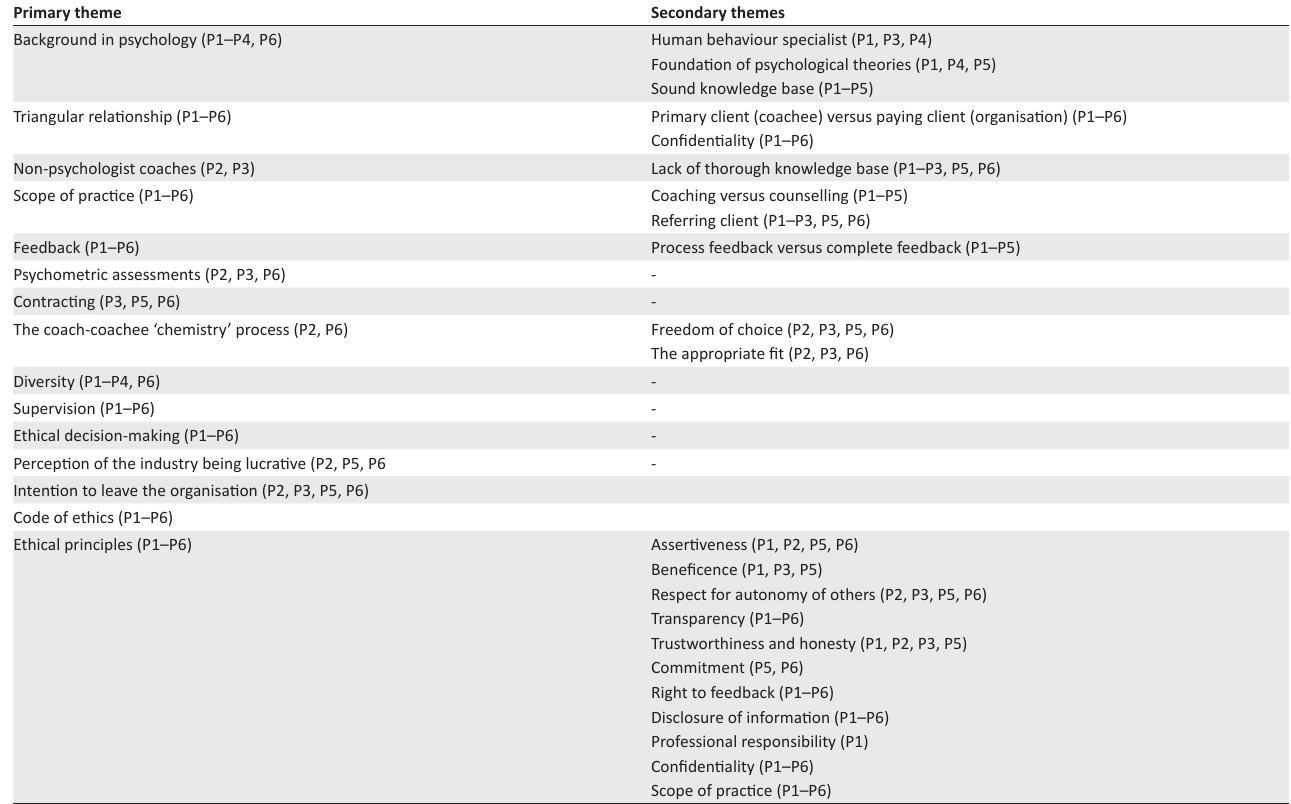
TABLE 1: Summary of primary and secondary